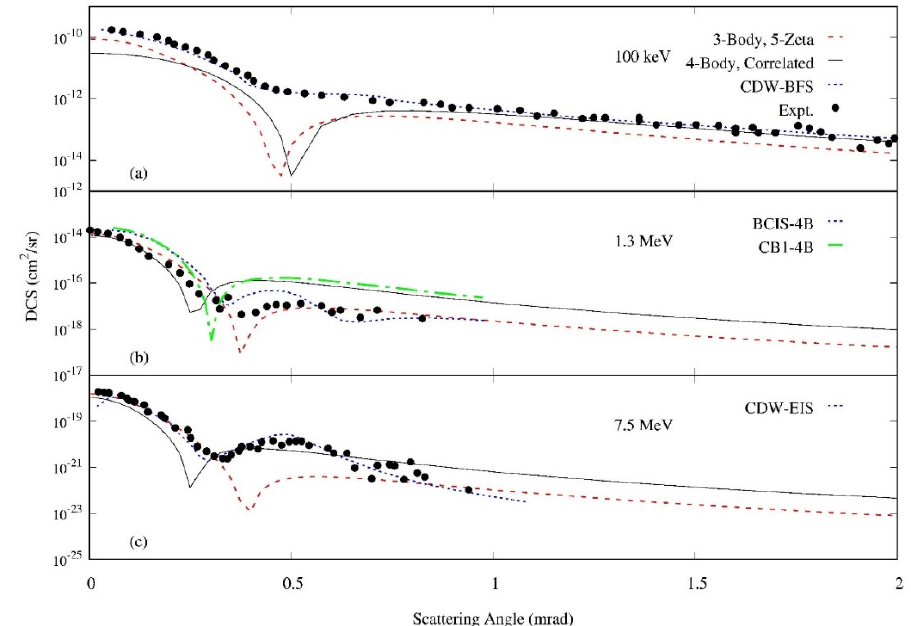
Figure 4. Differential cross sections for p + He single electron capture to the ground state with the residual He + ion also in the ground state. Results from the three-body and four-body models are compared to experimental results from ( a ) [7], ( b , c ) [6] and the theoretical models from (a) [7], (b) [31], and (c) [47]. For (a), the captured electron is known to be in the ground state in, however for (b,c), the final captured state of the electron is not specified. Incident projectile energies are (a) 100 keV, (b) 1.3 MeV, and (c) 7.5 MeV.